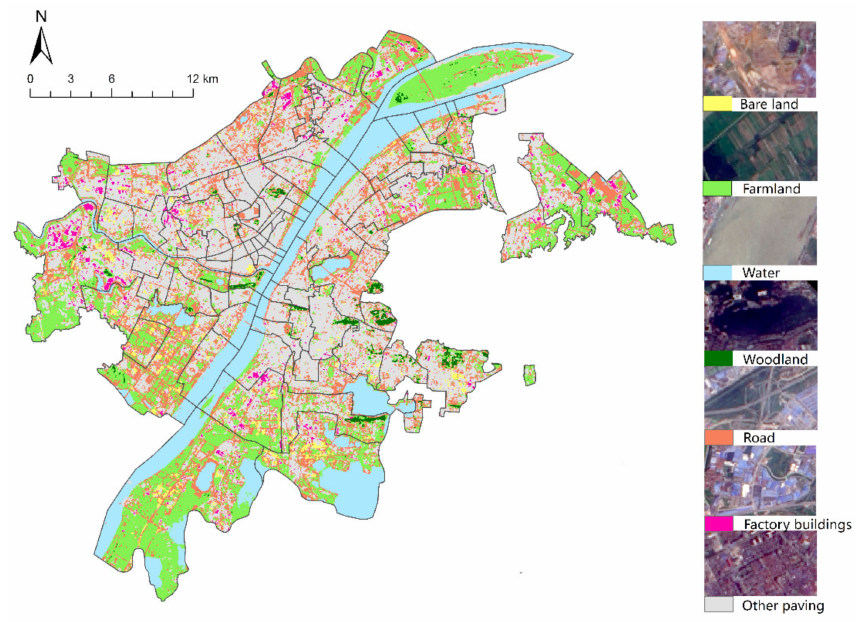
Figure 4. Land cover in the central area of Wuhan